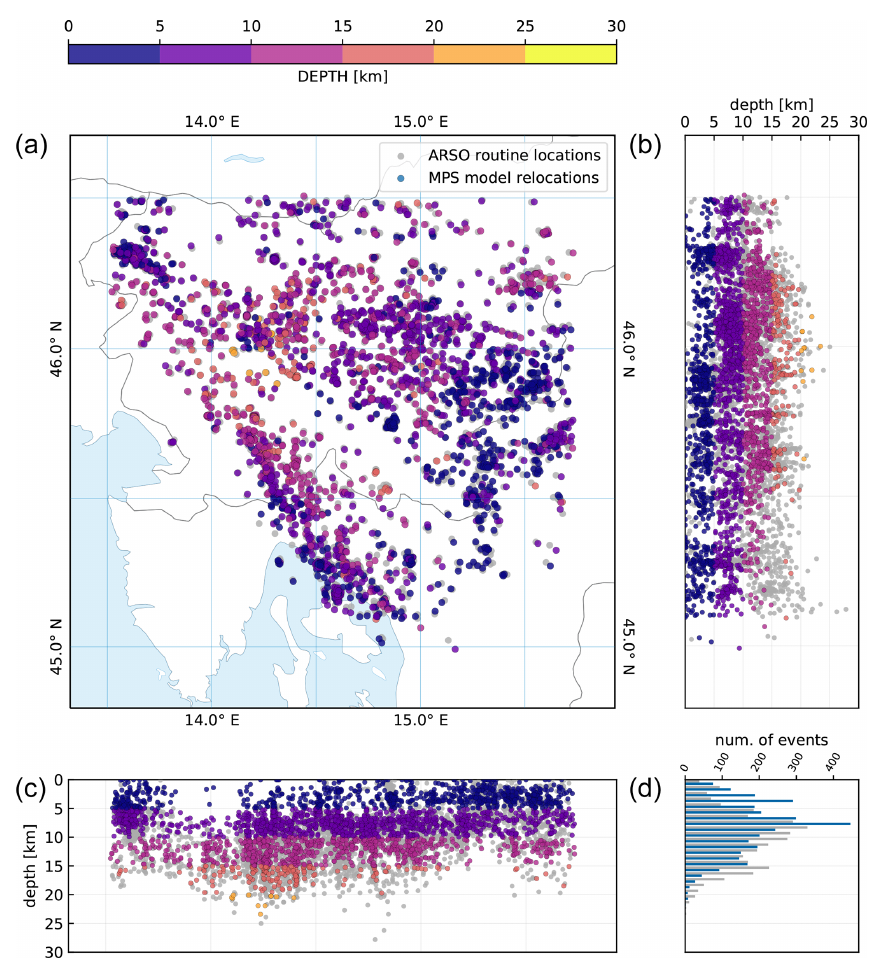
Figure 11. Relocation of 3282 earthquakes (a) with the MPS velocity model (velocities and station delays). The relocation included earth- quakes between 2004 and 2018 with a maximum azimuthal gap of 180 ◦ and at least 10P arrivals and 5S arrivals with an uncertainty class below 3. Panels (b) and (c) show the hypocenters of earthquakes projected on N–S- and W–E- oriented profiles, respectively. The histogram in (d) shows the number of earthquakes in 1km depth bins for routine locations (grey) and relocations